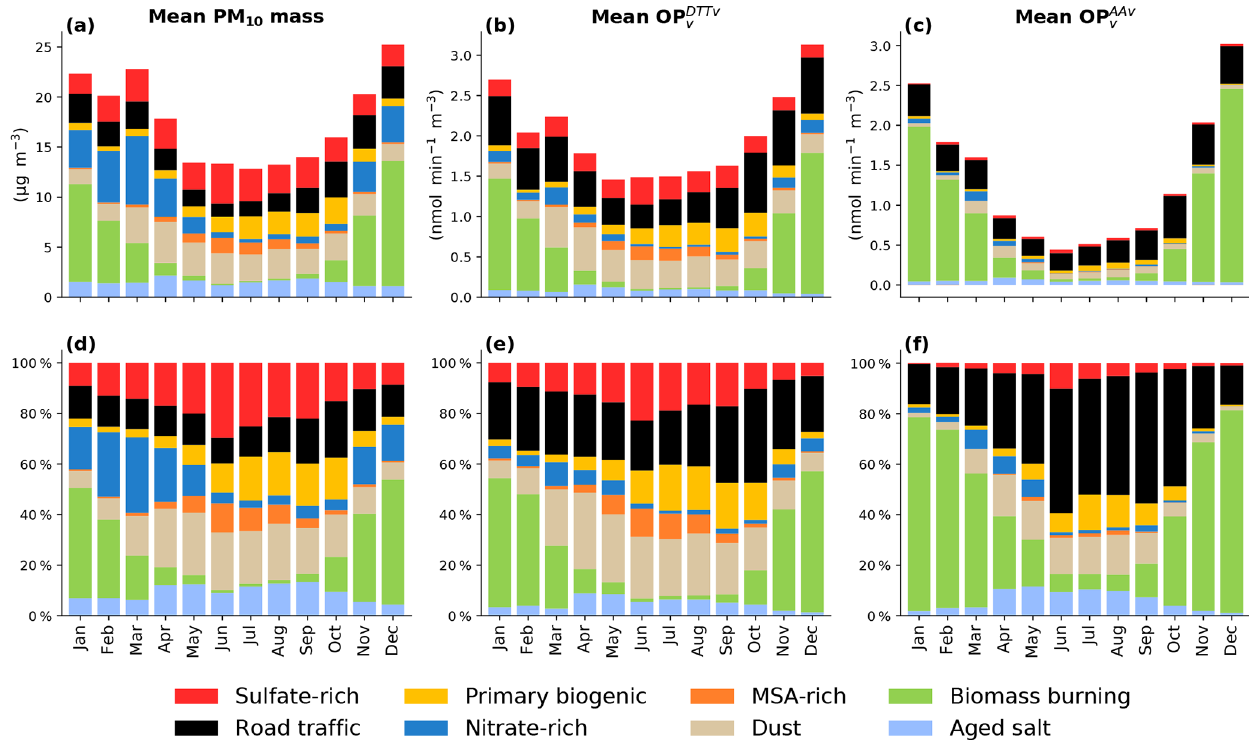
Figure 4. Mean monthly contribution of the eight main sources to the (a) PM 10 mass, (b) OP DTT v and (c) OP AA v , taking into account each source contribution of every site; their respective normalized contributions are presented in (d) PM 10 mass, (e) OP DTT v and (f) OP AA v .